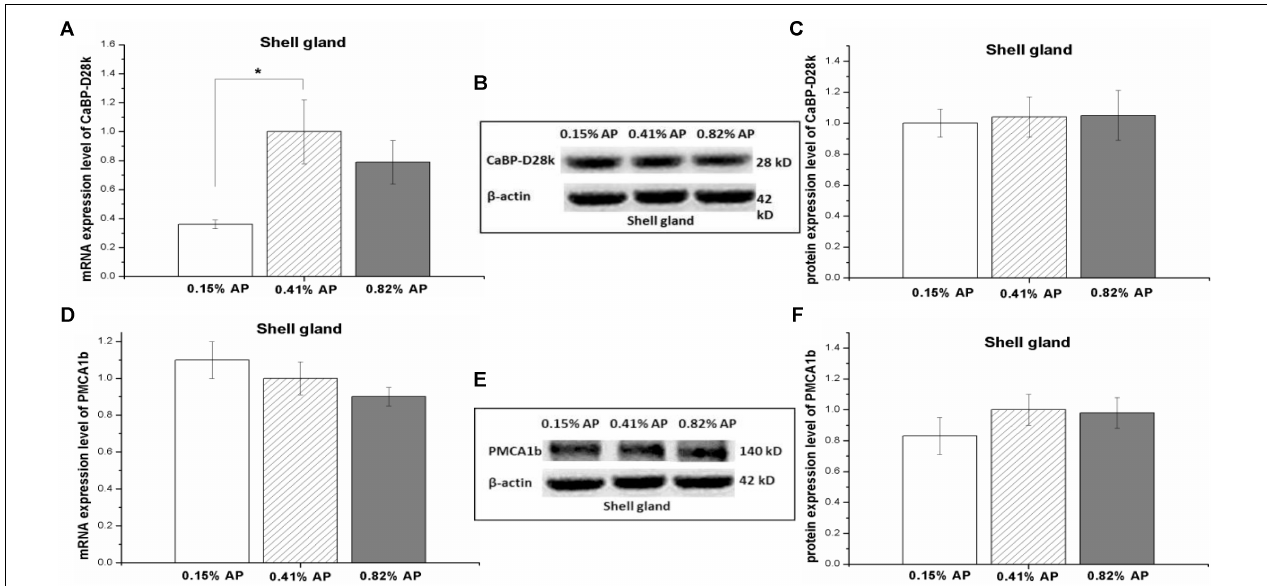
FIGURE 5 | Effect of dietary available phosphorus levels (AP, 0.15, 0.41, and 0.82%) on the mRNA expression level and protein expression level of calbindin-D28k (CaBP-D28k) and plasma membrane calcium ATPase 1b (PMCA1b) in shell gland of laying hens. The mRNA and protein levels of CaBP-D28k (A–C) ; the mRNA and protein expression levels of PMCA1b (D–F) . The values are presented as the means ± SEM ( n = 8); ∗ P <